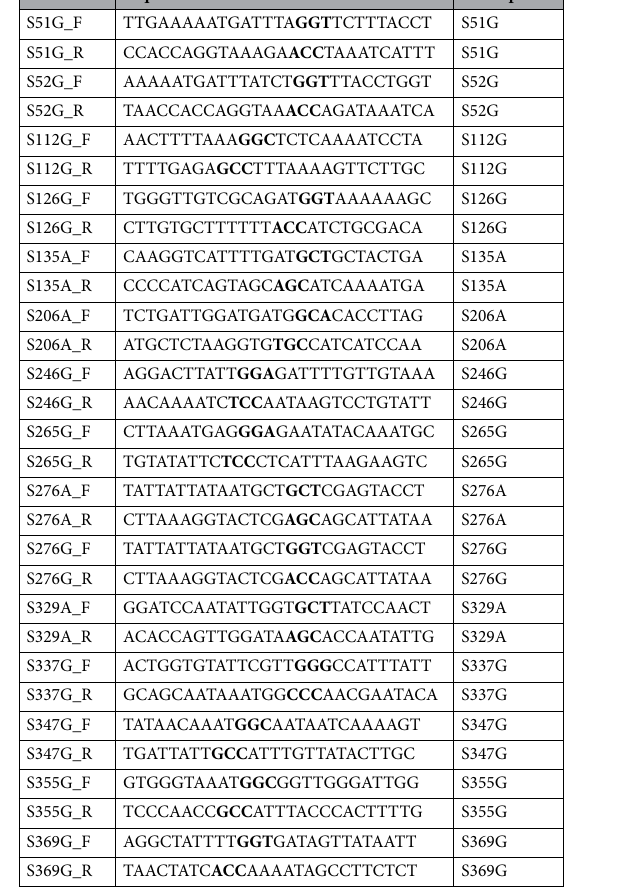
Table 1. List of primers. Mutated nucleotides are in